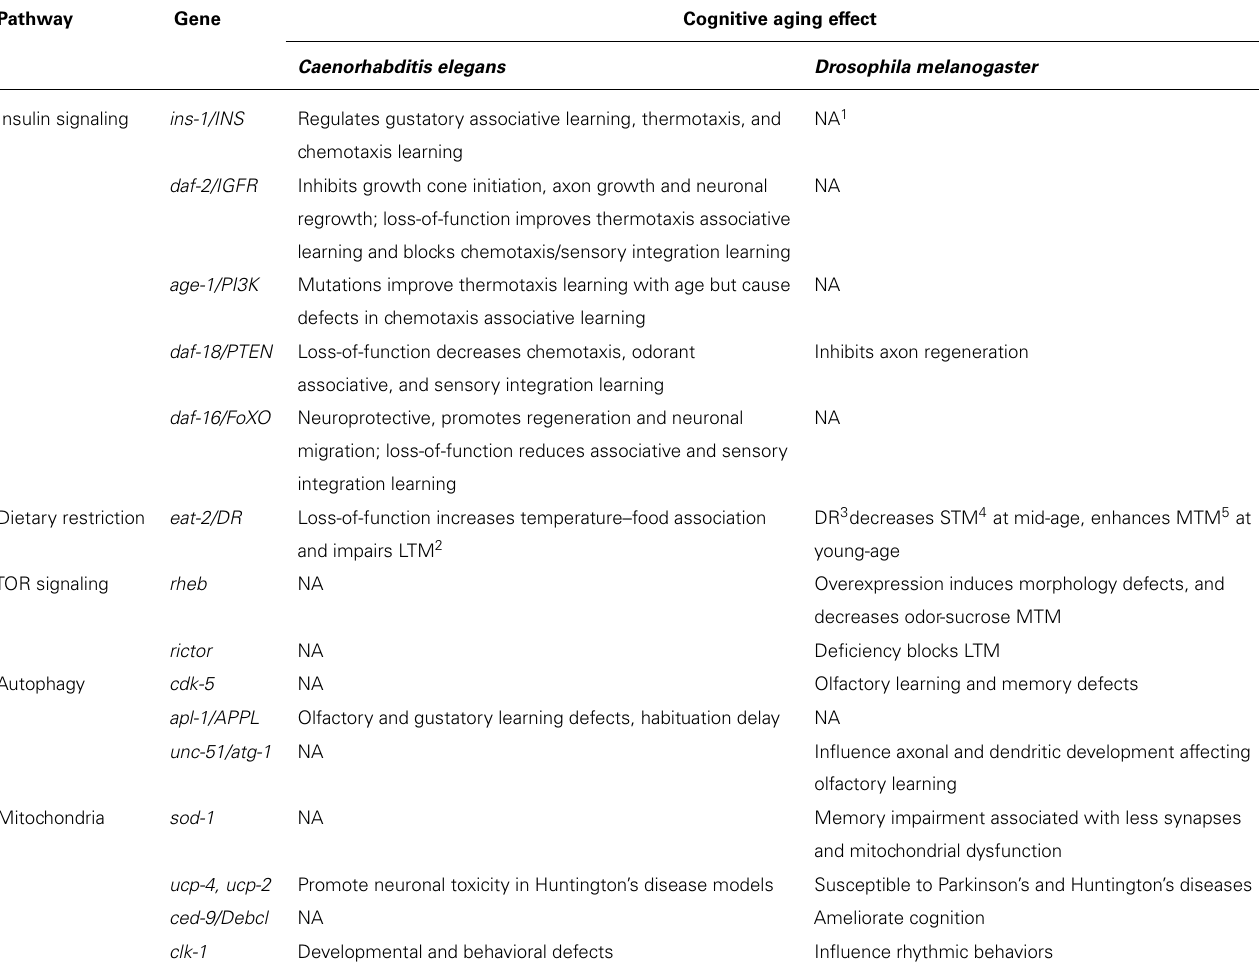
Table 1 | Conserved signaling pathway genes and cognitive aging in worms and flies.